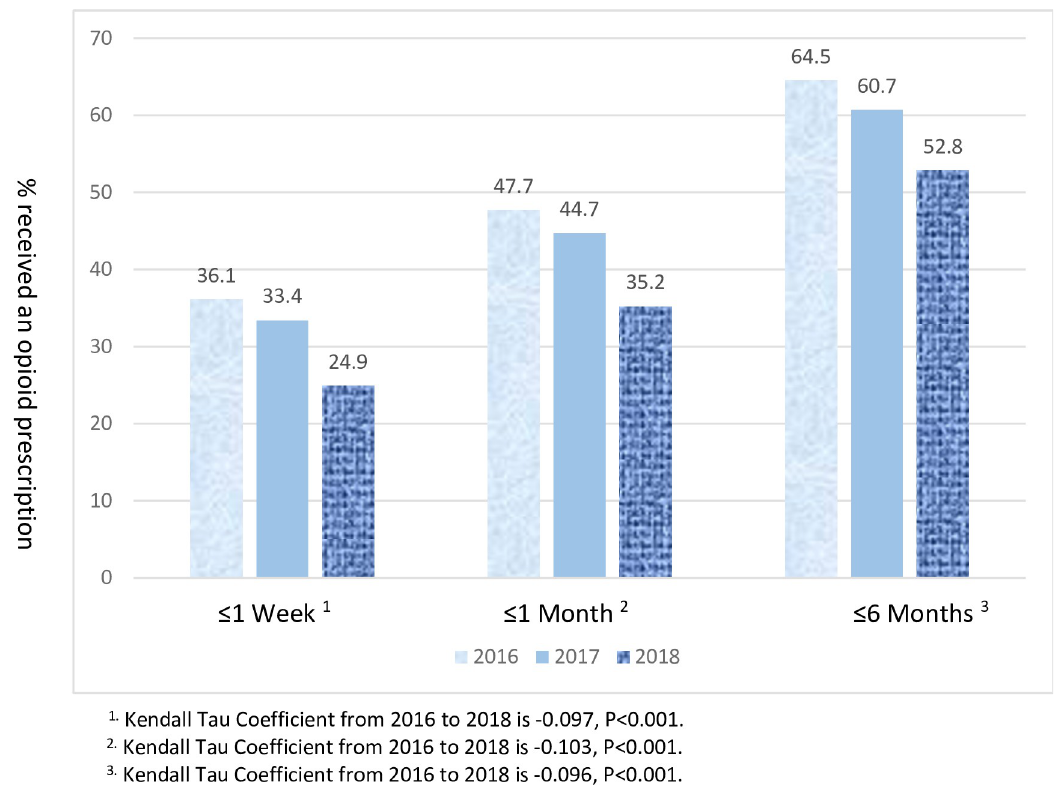
Fig 1. Percent of workers who received an opioid prescription within I week, I month and 6 months of an injury for which they received a paid wage replacement WC claim, by year and combined 2016–2018 (n = 46,934). 1. Kendall Tau Coefficient from 2016 to 2018 is -0.097, P < 0.001. 2. Kendall Tau Coefficient from 2016 to 2018 is -0.103, P < 0.001. 3 Kendall Tau Coefficient from 2016 to 2018 is -0.096, P <